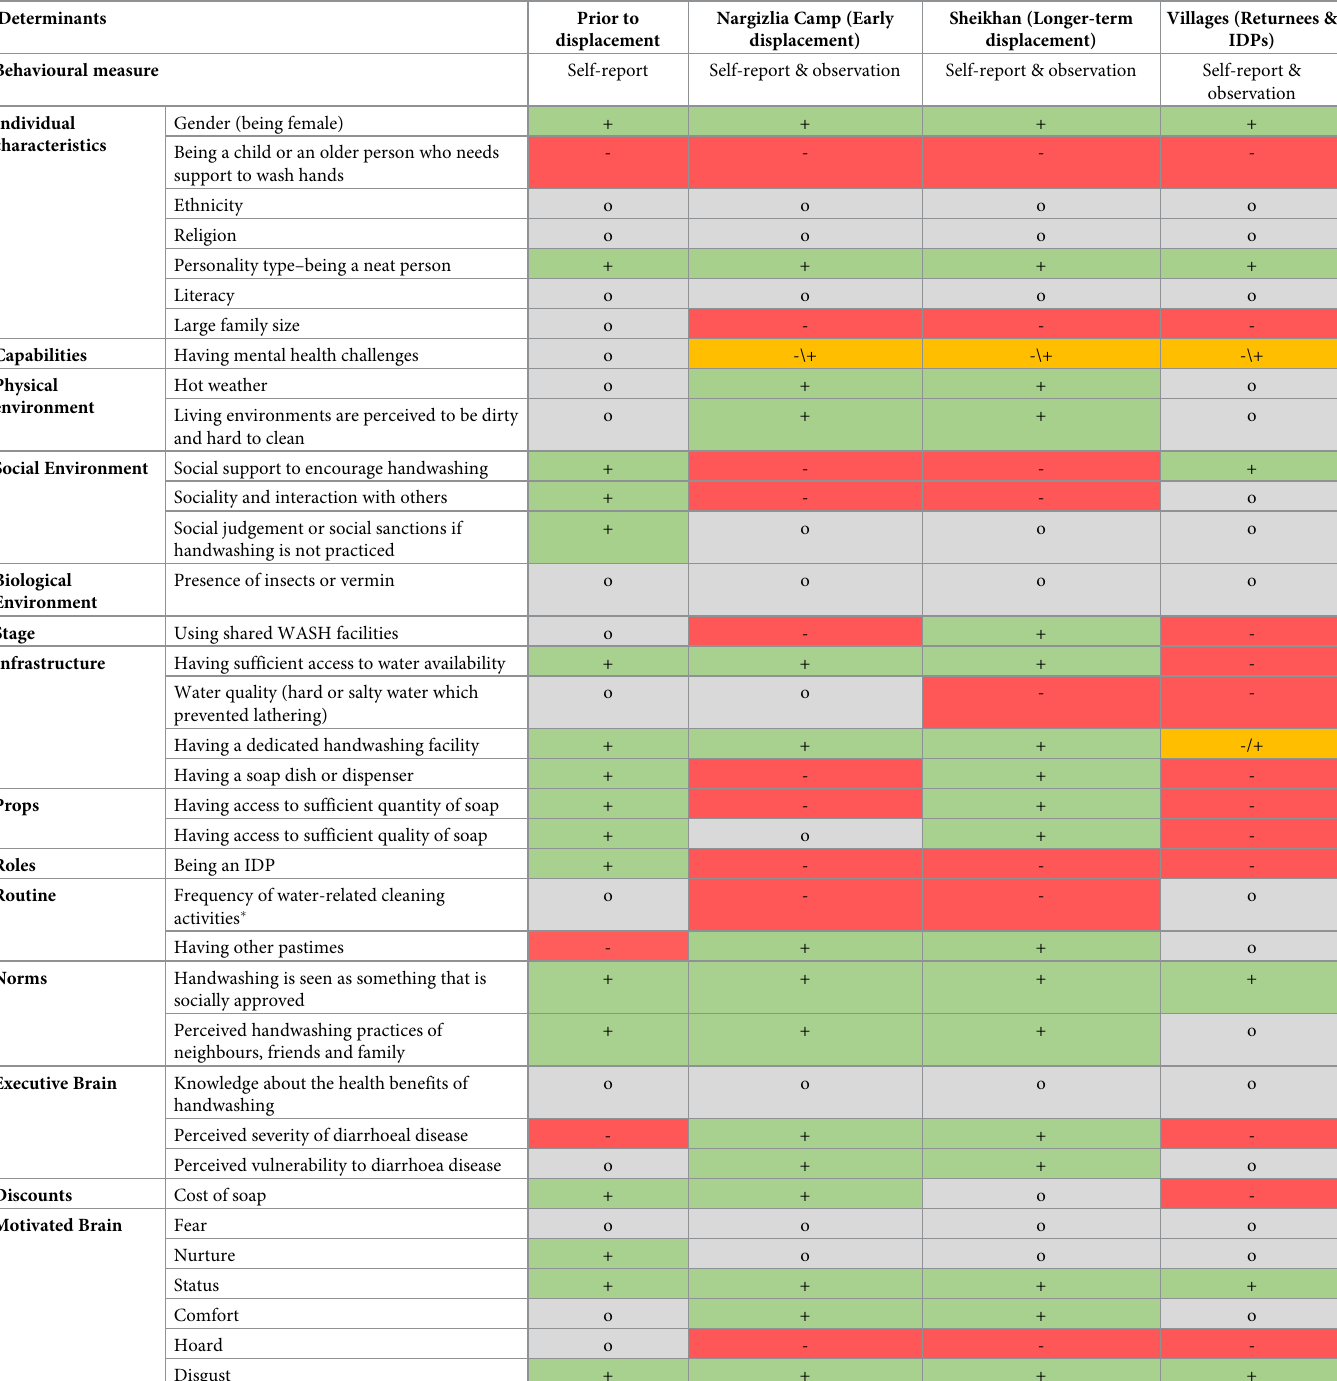
Table 4. Associational relationships between identified determinants and handwashing with soap at critical times. Determinants